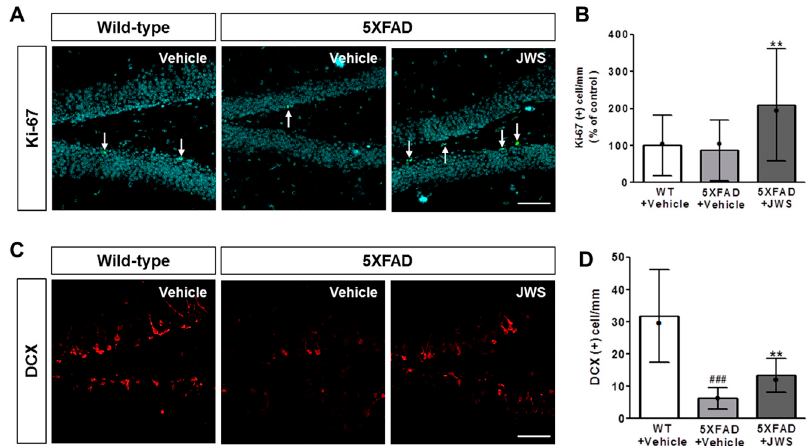
Figure 5. Effects JWS on cell proliferation and differentiation. ( A ) Representative images of brain sections immunostained with anti-Ki67 antibody. ( B ) The numbers of Ki67-positive cells in mice in the jowiseungchungtang (JWS)-treated group is higher compared to mice in the 5XFAD vehicle group. ( C ) Representative images of brain sections immunostained with anti-DCX antibody. ( D ) The numbers of DCX-positive cells in mice in the JWS-treated group was higher compared to mice in the 5XFAD vehicle group. Scale bar = 100 µ m. Data are presented as mean ± SD ( n = 5 in each group). Significance by Tukey’s post hoc test following one-way ANOVA is indicated as ** p < 0.001 versus 5XFAD + vehicle group and ### p < 0.001 versus WT + vehicle group. Median value is indicated as •.